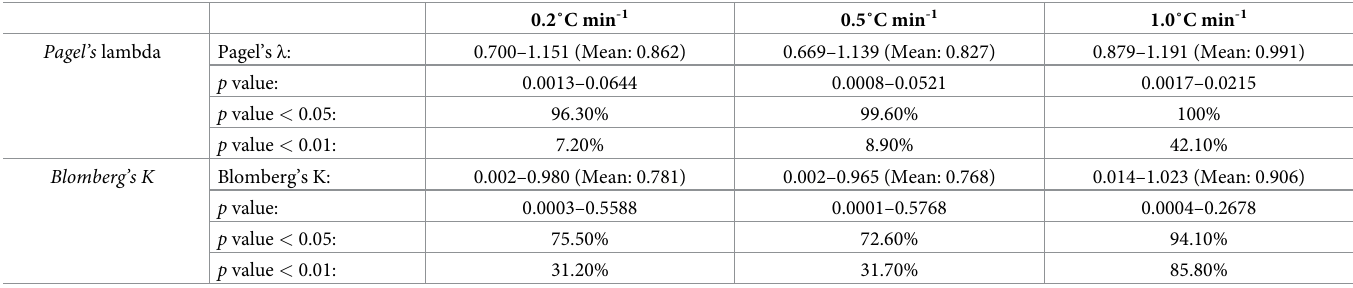
Table 3. Phylogentic signals, Pagel’s λ and Blomberg’s K, for dynamic assay 0.2˚C min -1 , 0.5˚C min -1 , 1.0˚C min -1 (1000